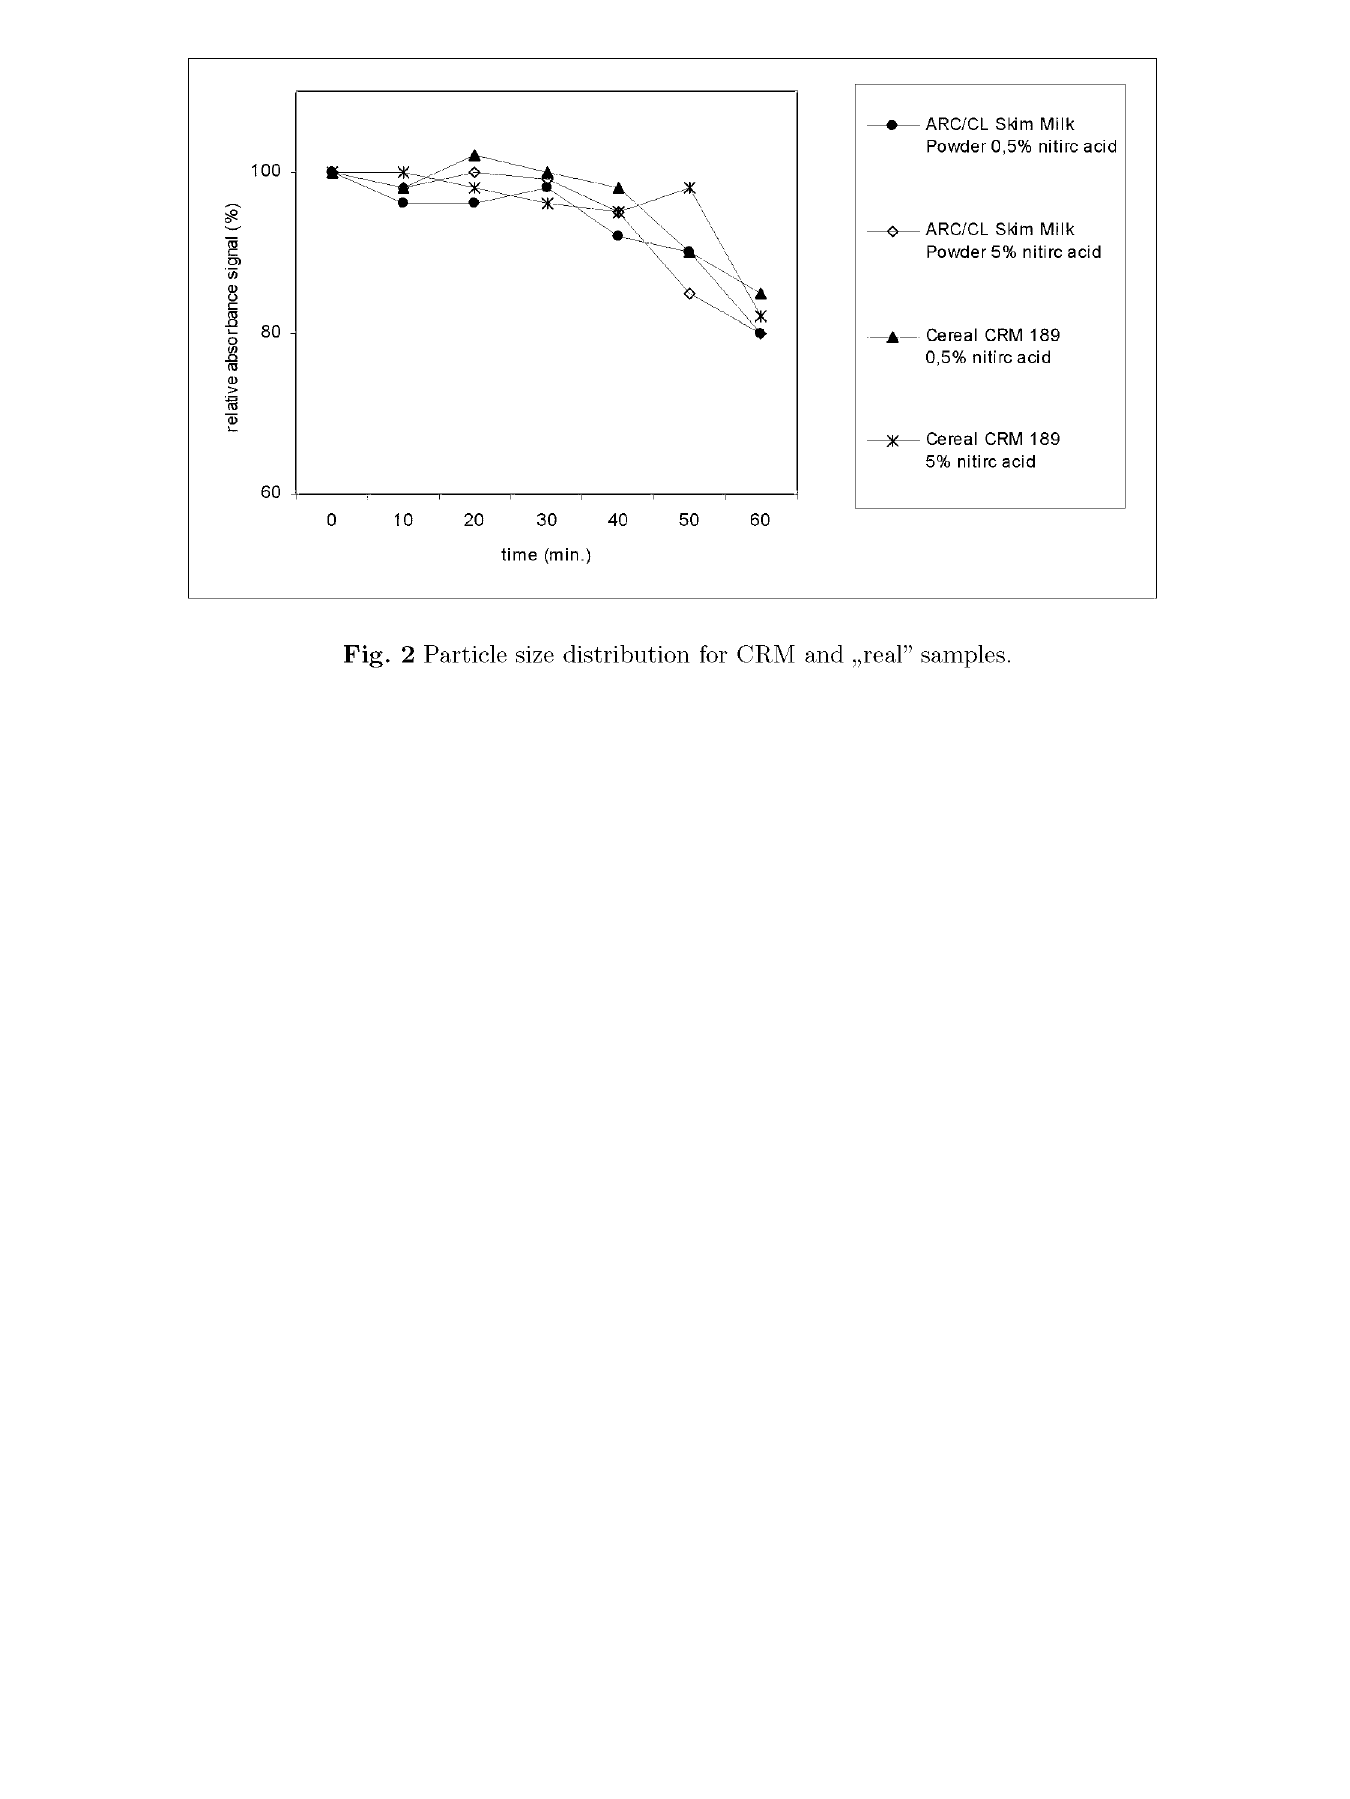
Fig. 2 Particle size distribution for CRM and .real"